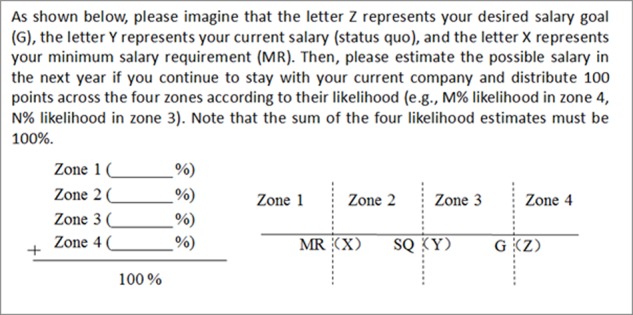
Expected salary distribution task.